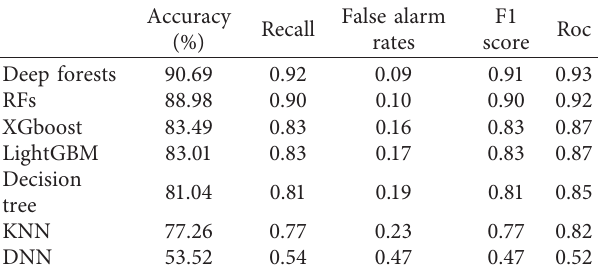
Table 3: Average predictive performance of different